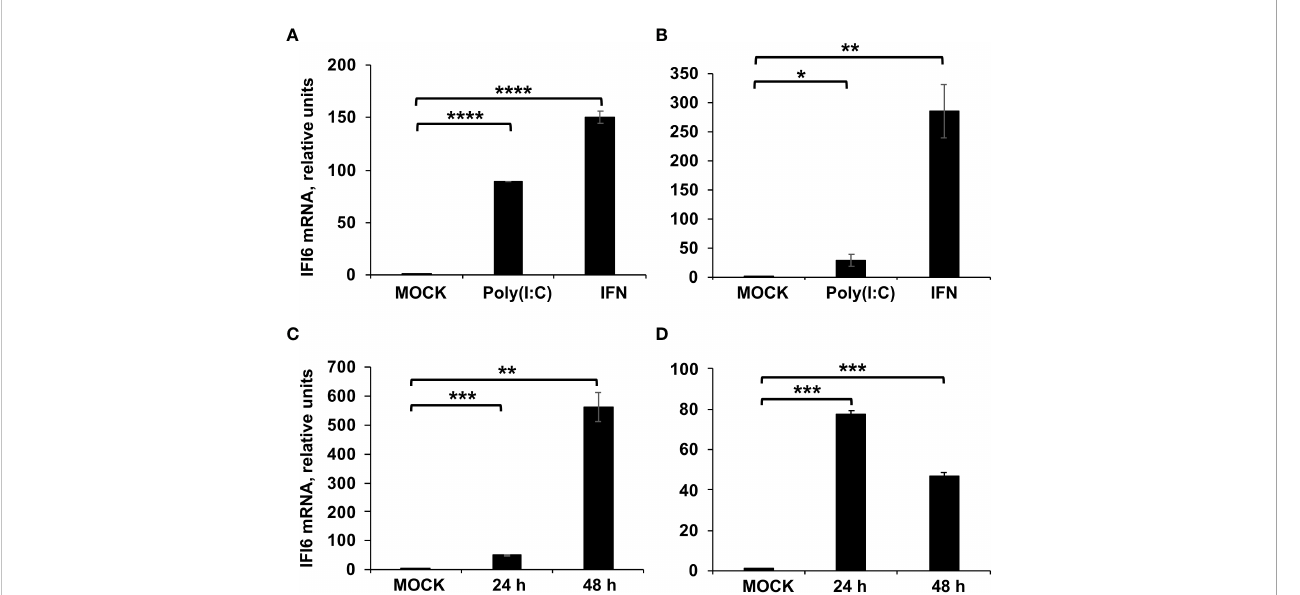
FIGURE 1 IFI6 expression is induced by poly(I:C) transfection, IFN treatment, and IAV and SARS-CoV-2 infection. (A, B) A549 and HAP-1 cells, respectively, were transfected with poly(I:C) or treated with IFN during 16 h. (C) A549 cells were infected with IAV (MOI 3) during 24 and 48 hpi. (D) A549 cells overexpressing hACE-2 were infected with SARS-CoV-2 (MOI 1) during 24 and 48 hpi. (A – D) The levels of IFI6 mRNAs were evaluated by RT-qPCR and compared to the levels in non-treated or non-infected cells (mock). Error bars represent standard deviations (SD) of results of measurements performed in triplicate wells. *P<0.05, **P<0.01, ***P<0.001, ****P<0.0001 using an Student ’ s t